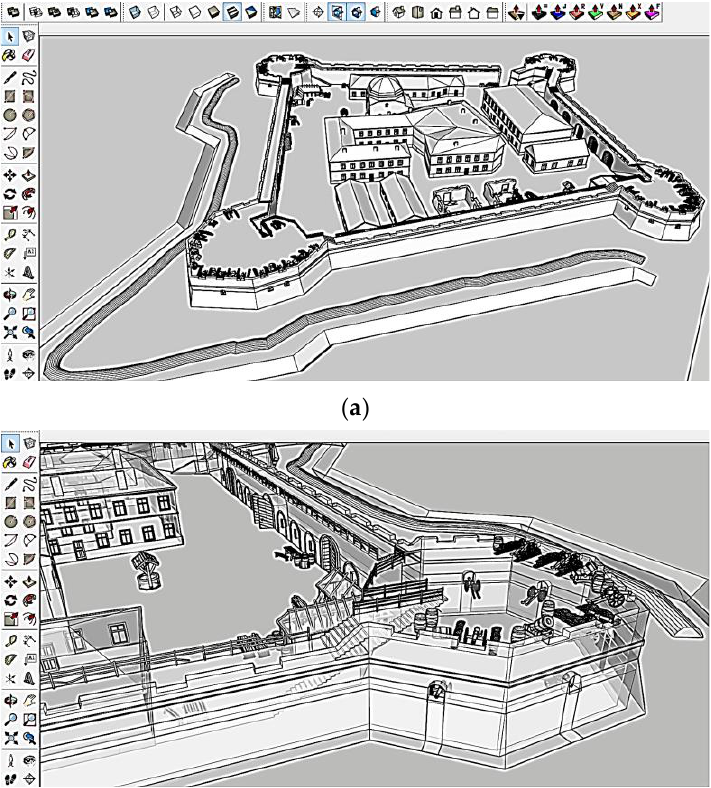
Figure 6. The general 3D model of the object ( a ) and its parts ( b ).